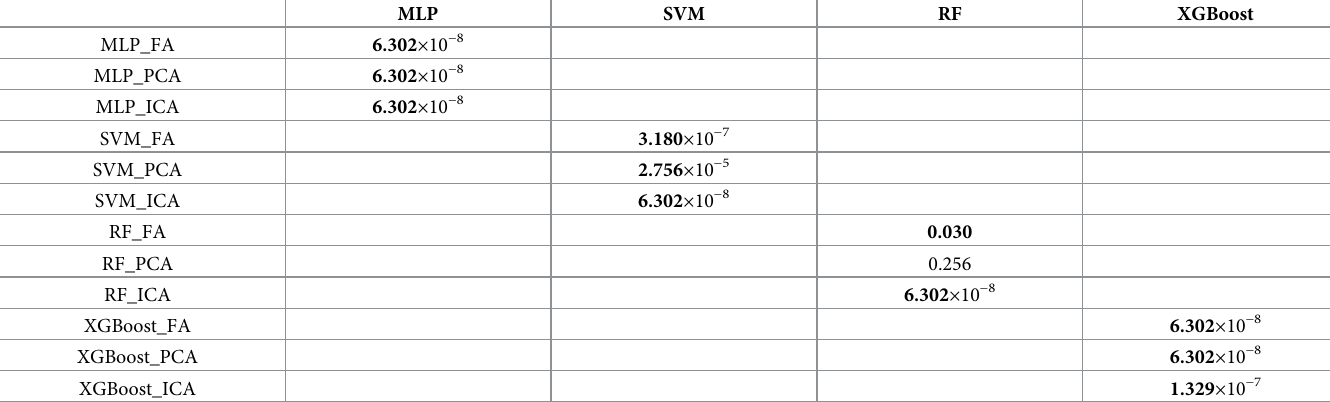
Table 4. Wilcoxon rank-sum tests for the MLP, SVM, RF, XGBoost, and the use of feature extraction, based on the StatLib dataset in terms of RMSE ( p -values less than 0.05 are highlighted in bold).